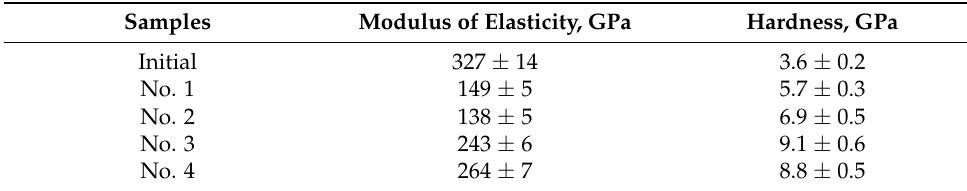
Table 2. Results of nanoindentation of 30CrMnSiA EPTCH